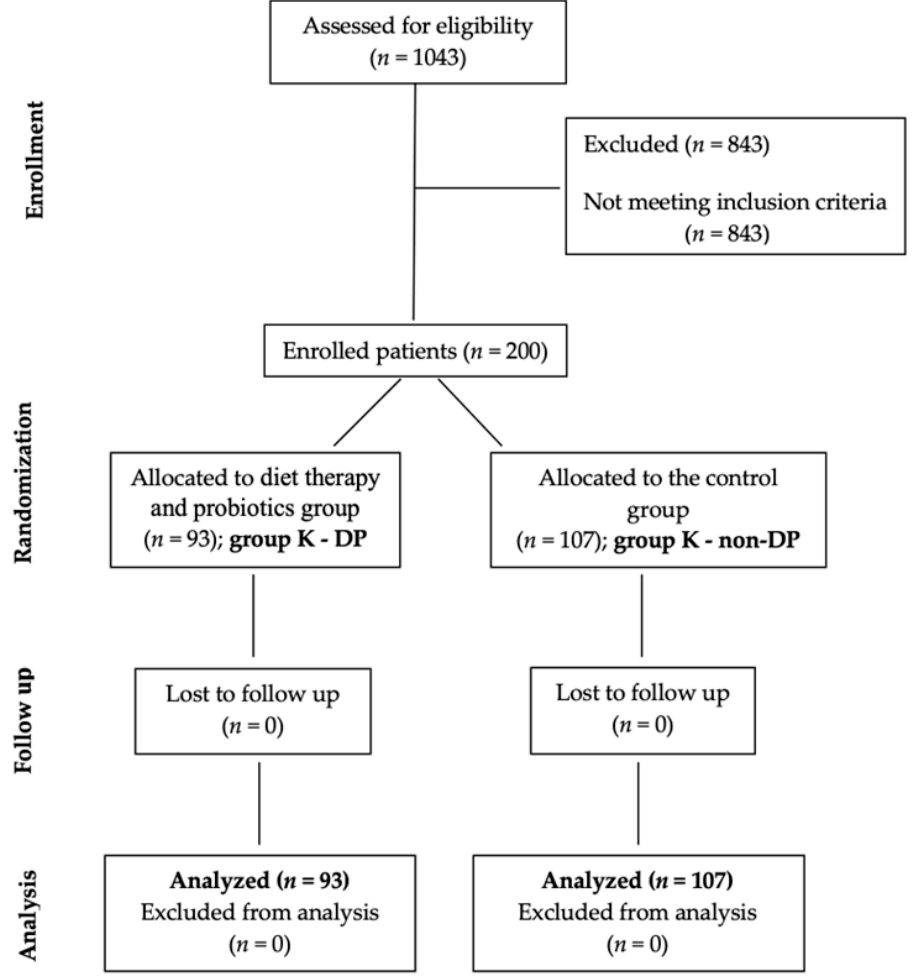
Figure 2. CONSORT flow diagram of the study.